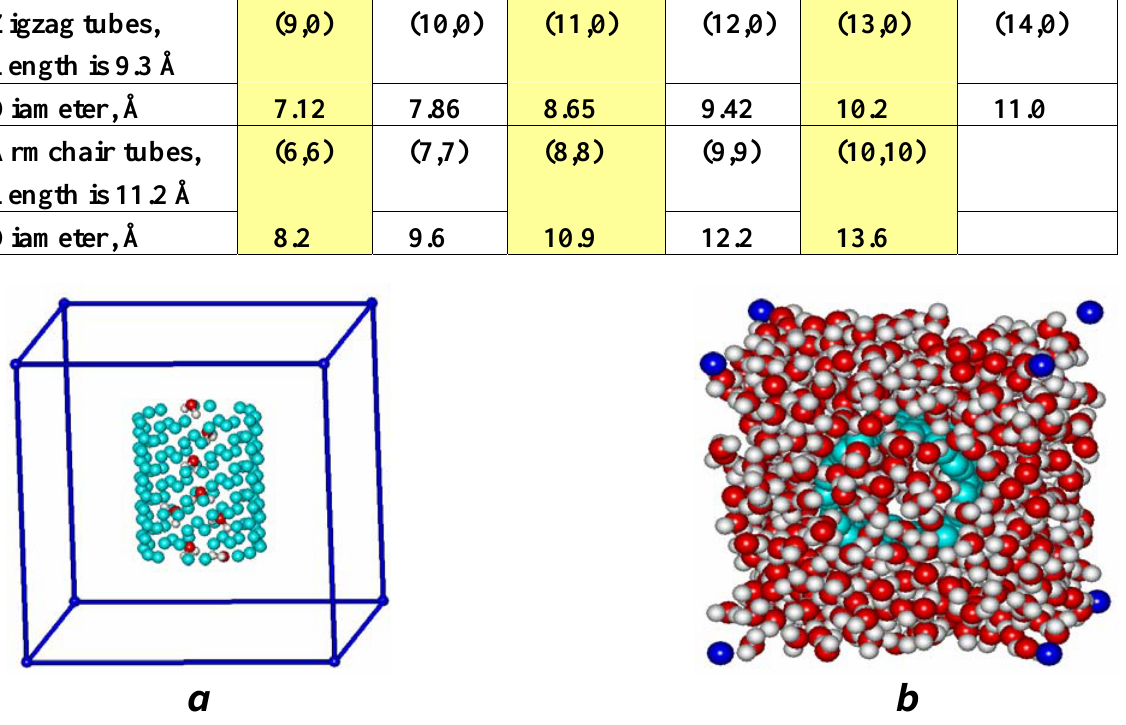
Table 1. Parameters of investigated CNs. Zigzag tubes,